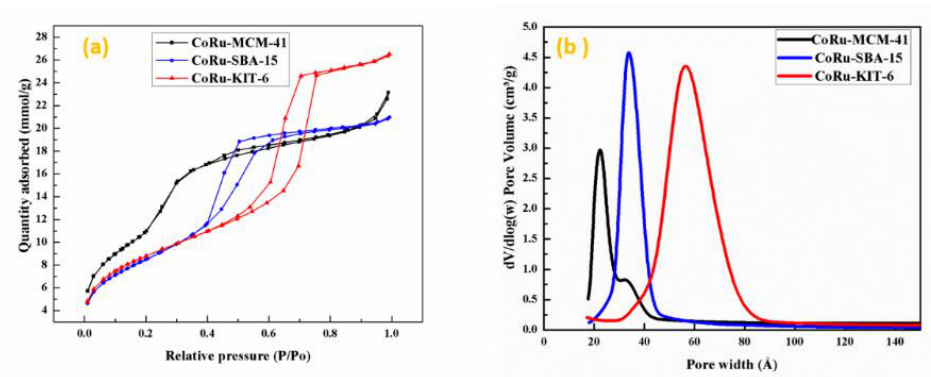
Figure 1. ( a ) N 2 adsorption–desorption isotherms of CoRu-S (S = MCM-41, SBA-15, KIT-6) and ( b ) pore size distribution of the catalyst. Table 1. Brunner–Emmett–Teller (BET) surface area, pore size, pore volume and EDX metal loadings of synthesized catalysts.